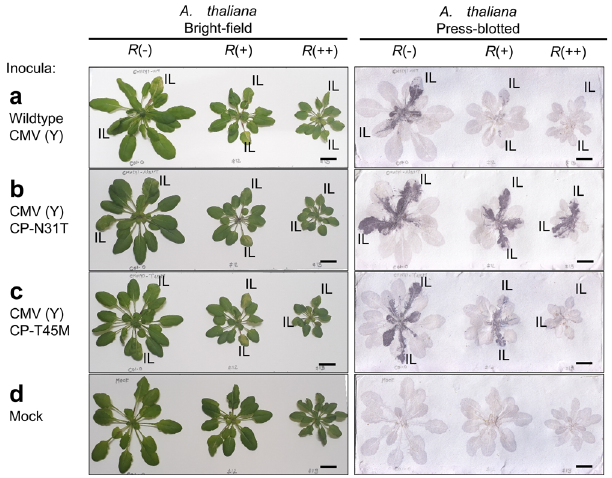
Fig. 3 Characterization of a CP-T45M variant in A. thaliana . Bright- fi eld observations and viral CP detection by press-blot analysis at 7 days after inoculation of WT CMV(Y) ( a ) or its CP variants CMV(Y) CP-N31T ( b ) and CMV(Y) CP-T45M ( c ), or mock inoculation ( d ) to A. thaliana ( R – ), ( R + ), and ( R ++ ) plants. Dark areas in press-blot analysis results indicate CP accumulation, visualizing the virus distribution. IL inoculated leaves. Scale bars = 1 cm. Similar results were observed in more than three replicates of